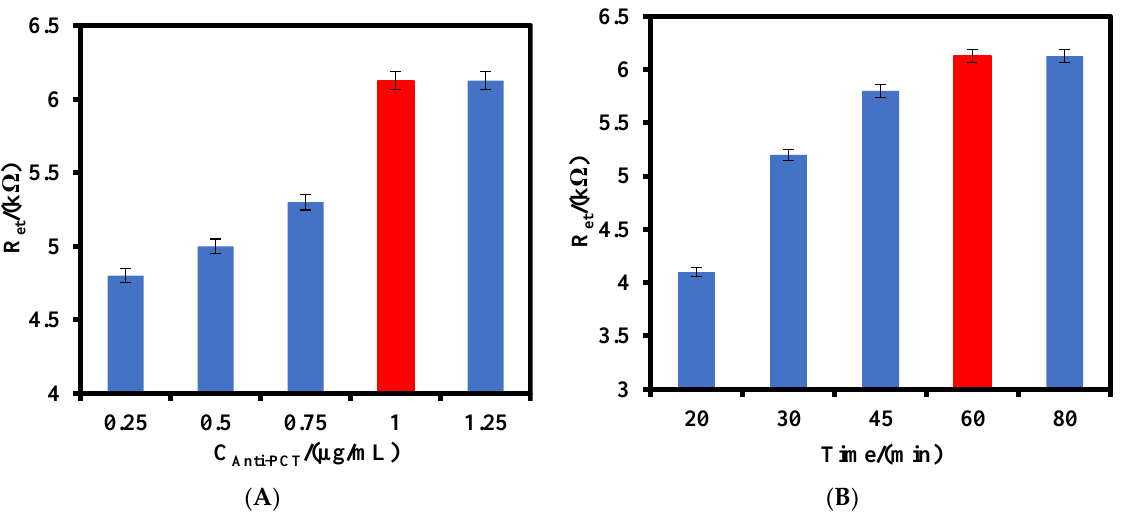
Figure 4. ( A ) Effect of anti-PCT antibody value and ( B ) the incubation time on the response of the IDGE/Au nano /3-MPA/Anti-PCT/BSA to 800 pg/mL PCT antigen.